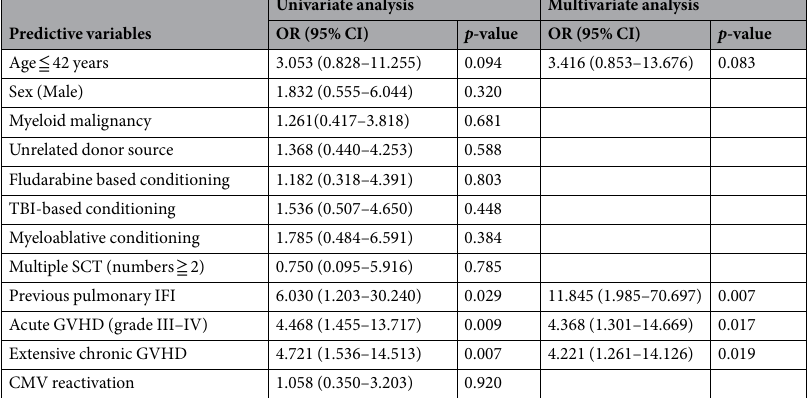
Table 3. Risk factors related to post-transplant thoracic air-leak syndrome. OR, odds ratio; CI, indicates confidence interval; TBI, total body irradiation; SCT, stem cell transplantation; IFI, invasive fungal infection; GVHD, graft-versus-host disease; CMV, Cytomegalovirus.